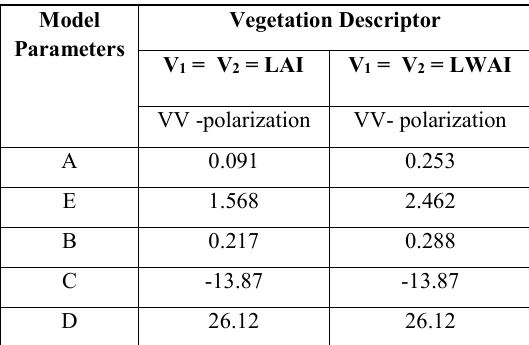
Table 3.Model parameters of modified WCM at VV polarization